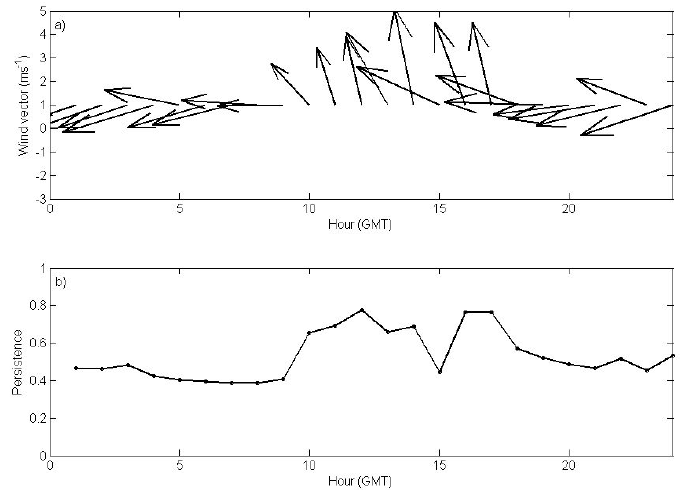
Fig. 7. (a) Diurnal cycle of the near-surface wind vector of the “representative day”, during the winter season at the Assergi site, as observed by the radar wind profiler. (b) Diurnal variation of wind persistence relative to the wind vector in the upper panel.